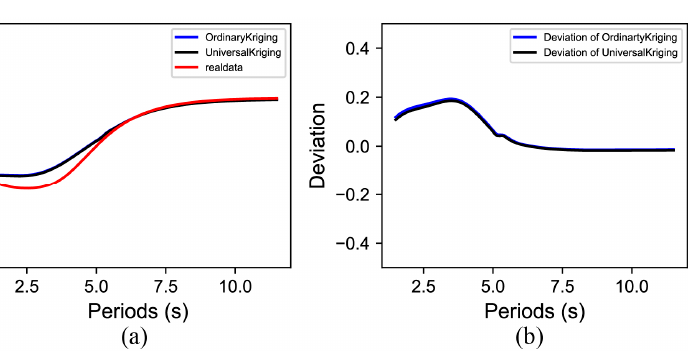
Figure A1. Comparison of dispersion curve interpolation results (127.76° E, 42.06° N ). The blue curve indicates the ordinary kriging results, while the black curve indicates those of universal kriging: ( a ) Comparison of dispersion curves; and ( b ) deviation of the OK (blue) or UK (black) re- sults.